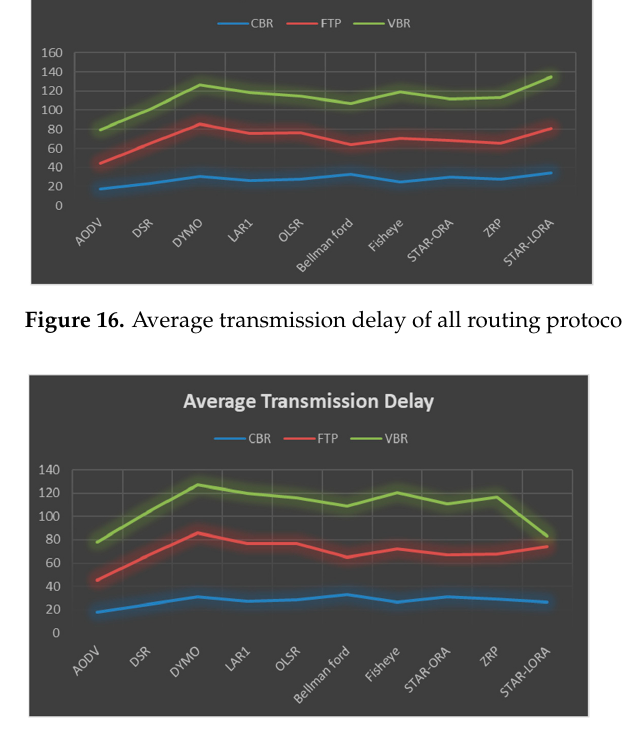
Figure 17. Average transmission delay of all routing protocols for 120 nodes .